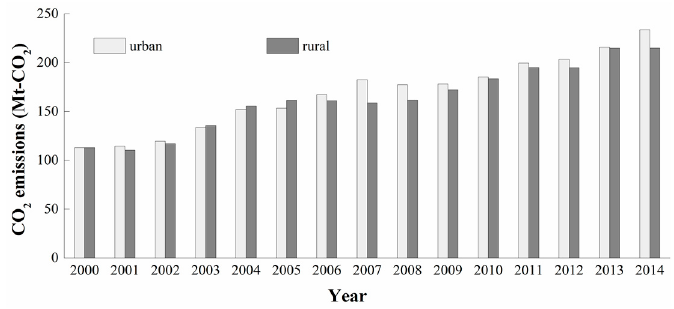
Figure 2. Household CO 2 emissions of different energy types in China (2000–2014).